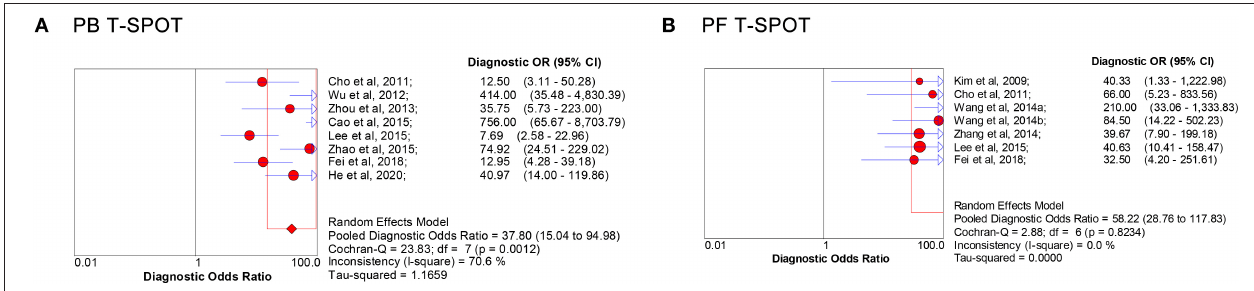
FIGURE 4 | Forest plot of estimates of DOR for PB T-SPOT (A) and PF T-SPOT (B) for the diagnosis of TP. Point estimates of DOR from each study are shown as solid circles, whose size reflects the total number of cases and controls. Error bars show 95% CI. Numbers indicate the reference numbers of studies. DOR,